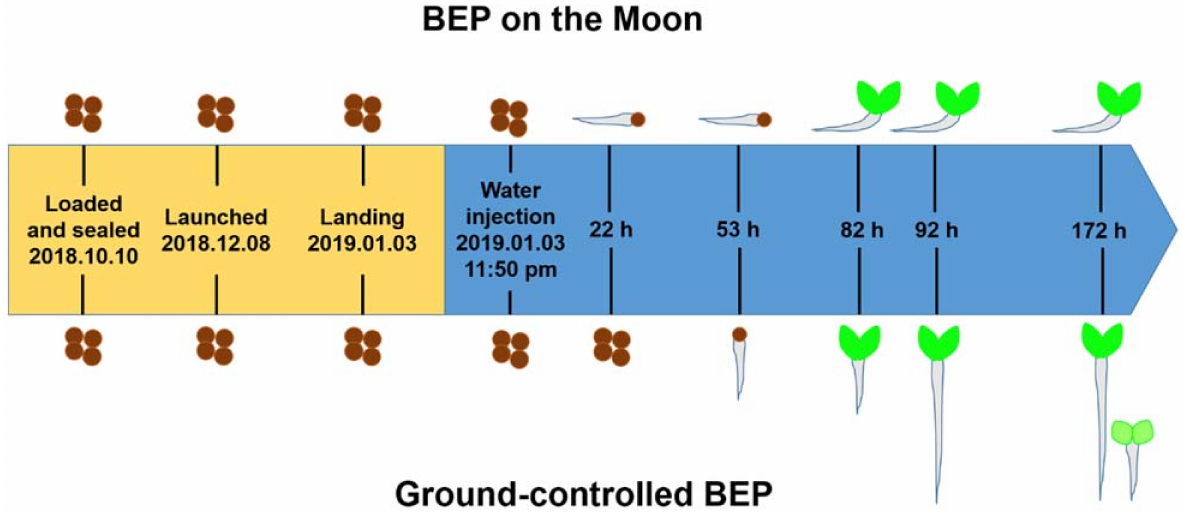
Figure 2. Brief comparison between the ground-controlled BEP and the BEP on the Moon. The brown circles represent seeds. The brown circles with a light grey tail represent germinated seeds. The green seedlings represent the seedlings of cotton or rapeseed. The time from the WIT is indicated in h. The germination of the cotton seed on the Moon was much faster than that on Earth. Horizontal elongation of the embryonic root and growth retardation 92 h after the WIT were observed in the BEP on the